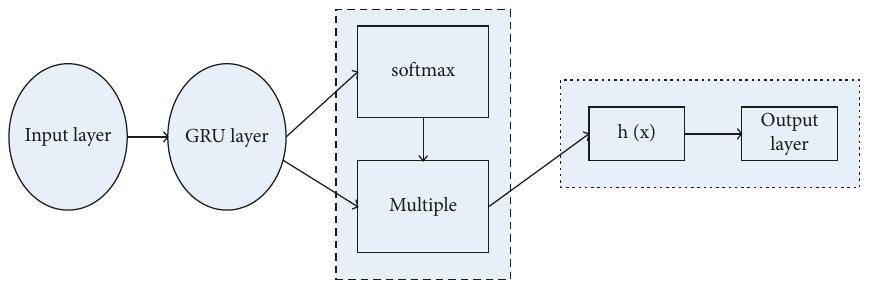
Figure 9: GRU basic